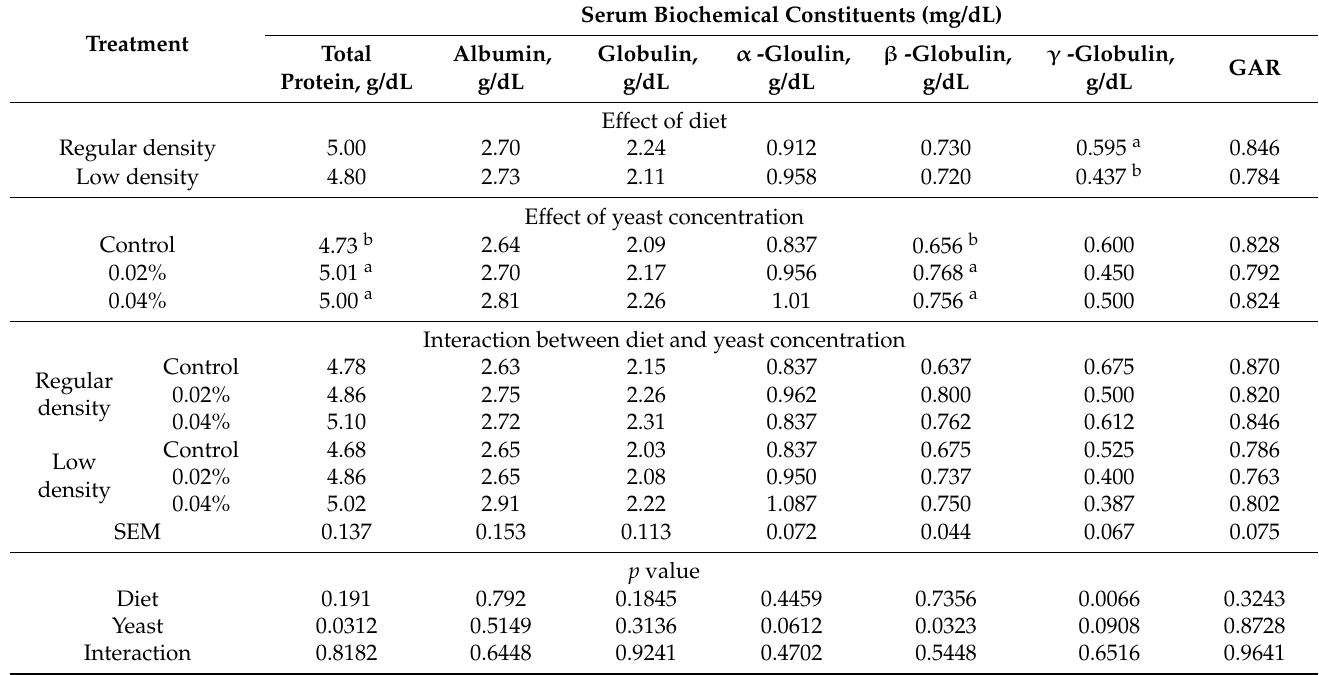
Table 4. Impact of different concentrations of Saccharomyces cerevisiae on the biochemical constituents of blood serum of broilers fed regular- and low-density diets from days 1 to 38 of